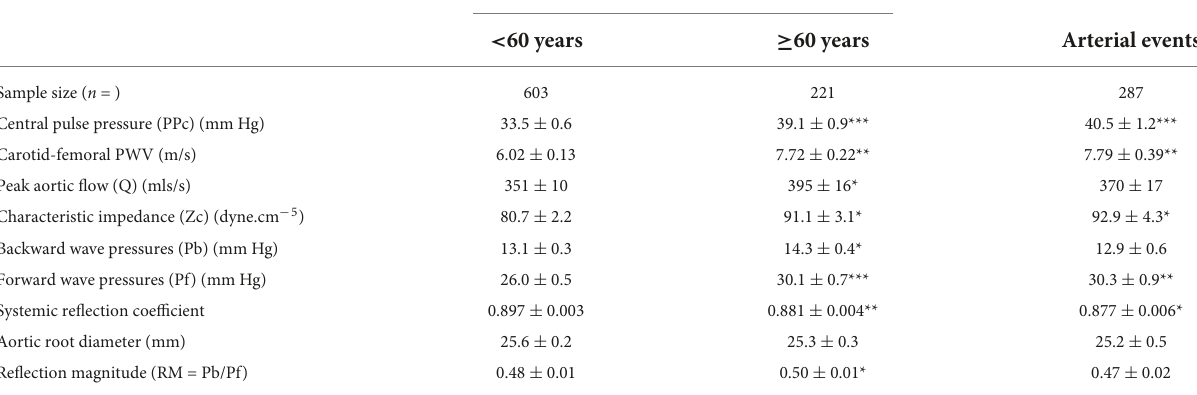
TABLE 2 Multivariate adjusted central arterial